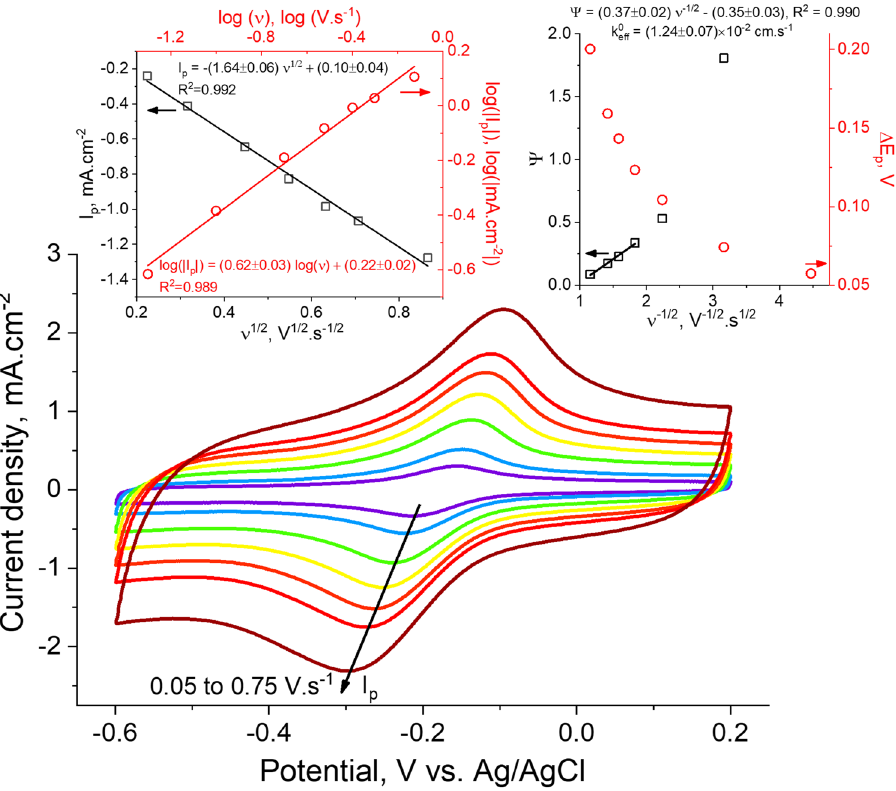
Figure 6. Cyclic voltammograms at varying scan rate (ν) for LIG/ZnO (profile C) electrode in aqueous solution of 0.5 mM [Ru(NH 3 ) 6 ] 3+ containing 0.1 M KCl. The log ( I P ) − log (ν) and I P − ν black squares, respectively, in the left inset) and the � E p (ν respectively, in the right inset) plots are also shown, along with pertinent